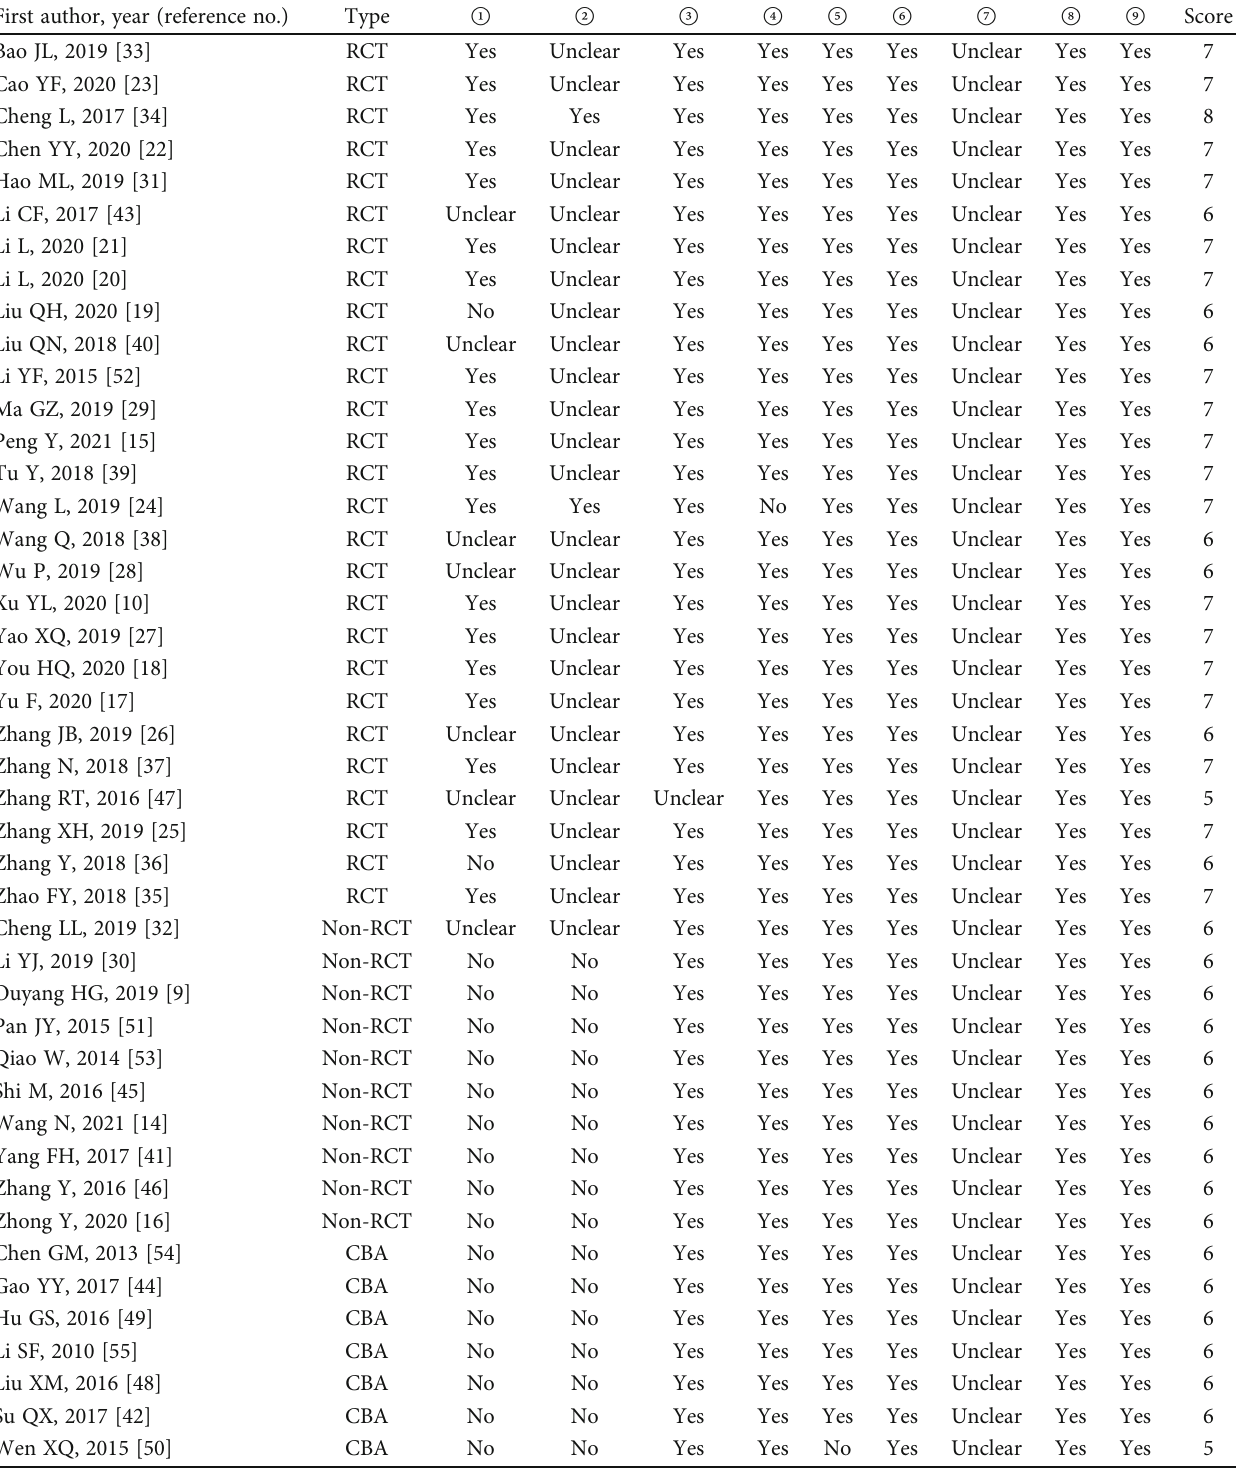
Table 2: Quality assessment of included